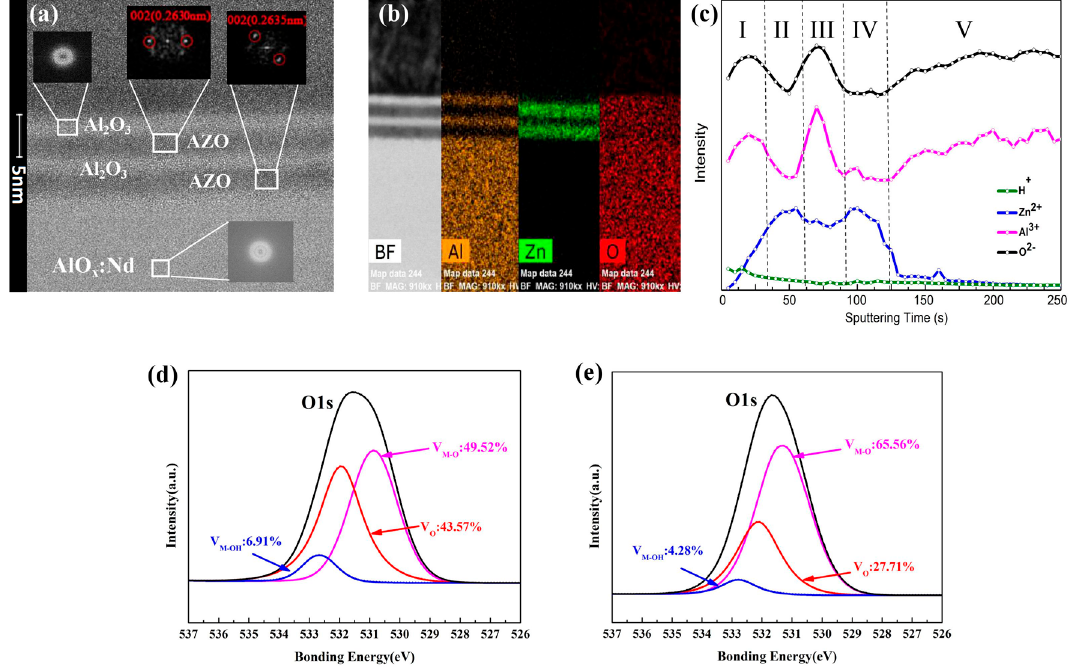
Figure 3. ( a ) Cross-sectional high-resolution transmission electron microscopy ( HRTEM) image of AZO/Al 2 O 3 /AZO/Al 2 O 3 channel layers in Device S3 and ( b ) the results of Al, Zn, O distribution detected by energy-dispersive X-ray spectroscope (EDS) mapping scan; ( c ) Time of flight secondary ion mass spectrometry (TOF-SIMS) results of H + , Zn 2+ , Al 3+ , and O 2 − ions for Device S3: Region I and III corresponds with Al 2 O 3 layers, Region II and IV corresponds with AZO layers, and Region V corresponds with the anodized AlO x :Nd gate insulator. X-ray photoelectron spectra (XPS) for the O1s region of ( d ) the PLD grown Al 2 O 3 layer and ( e ) the anodized AlO x :Nd gate insulator.